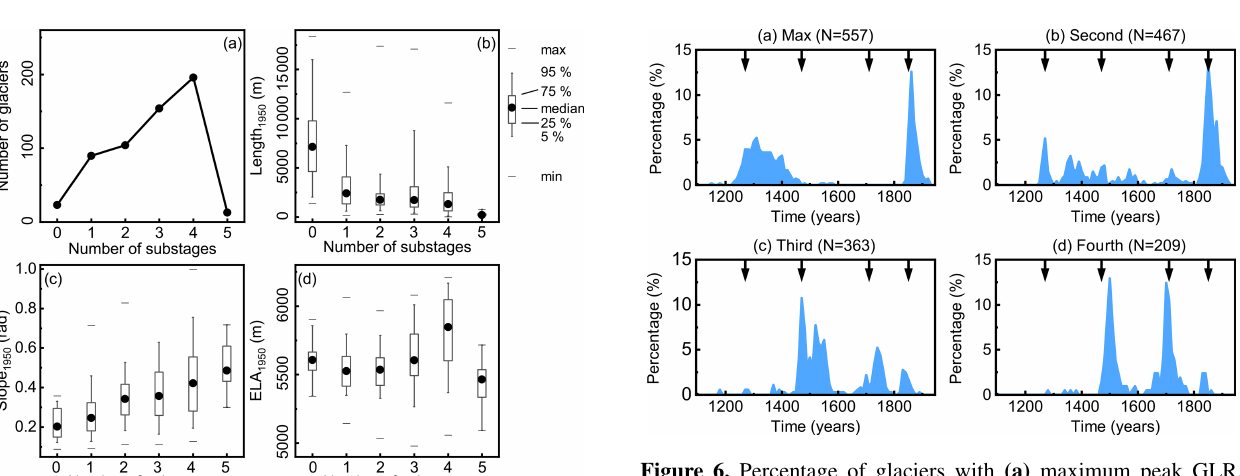
Figure 6. Percentage of glaciers with (a) maximum peak GLR, (b) the second largest peak GLR, (c) the third largest peak GLR, and (d) the fourth largest peak GLR over time in the MC experi- ment. The arrows represent the time of the four glacial substages, the 1270s (LIA-4), 1470s (LIA-3), 1710s (LIA-2), and 1850s (LIA-